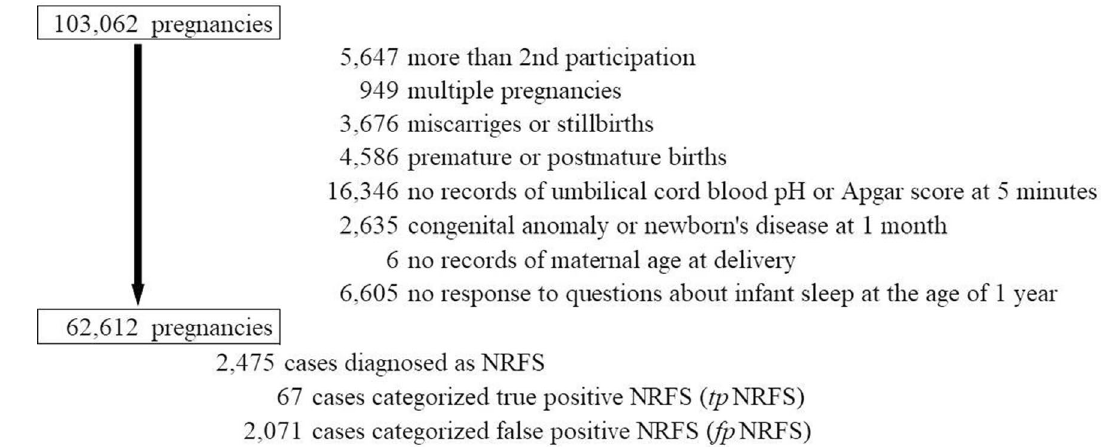
Figure 1. Population flow chart. NRFS: non-reassuring foetal status; true-positive NRFS ( tp NRFS): cases with umbilical cord pH < 7.2 and Apgar score of < 7 at 5 min after birth of all NRFS cases; false-positive NRFS ( fp NRFS): cases with umbilical cord pH ≥ 7.2 and Apgar score of ≥ 7 at 5 min after birth of all NRFS